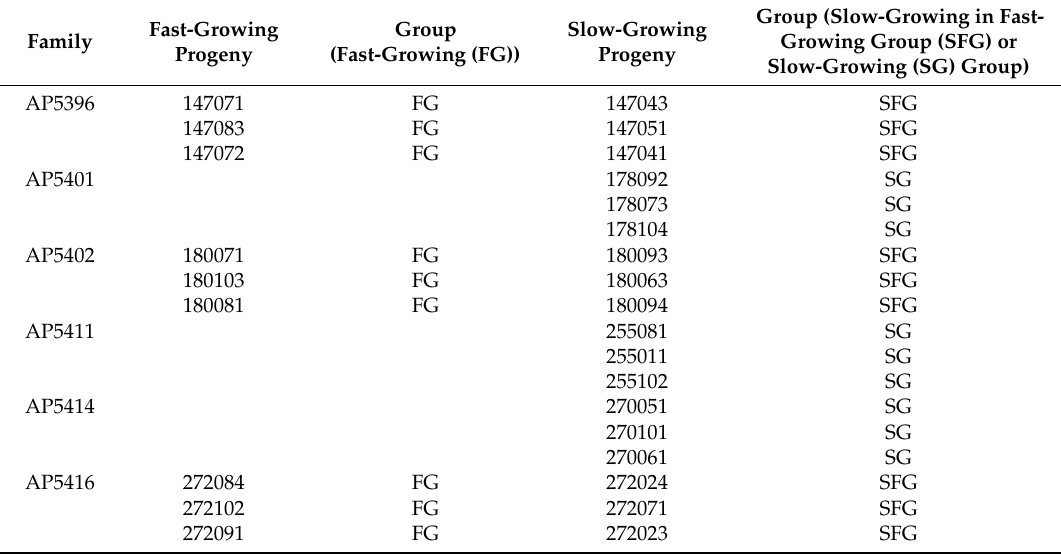
Figure 1. Mean stem volumes (cm 3 ) (+SE) for 6-year-old Alberta × Quebec cross-type families grown at two Alberta sites (AB1 and AB2). Significant differences between family means are indicated by different letters at p ≤ 0.05. Table 1. Family codes, and selected progeny for each group type, fast-growing (FG), slow-growing (SG), and slow fast-growing (SFG), based on 6-year-old growth from two field sites (AB1 and AB2).